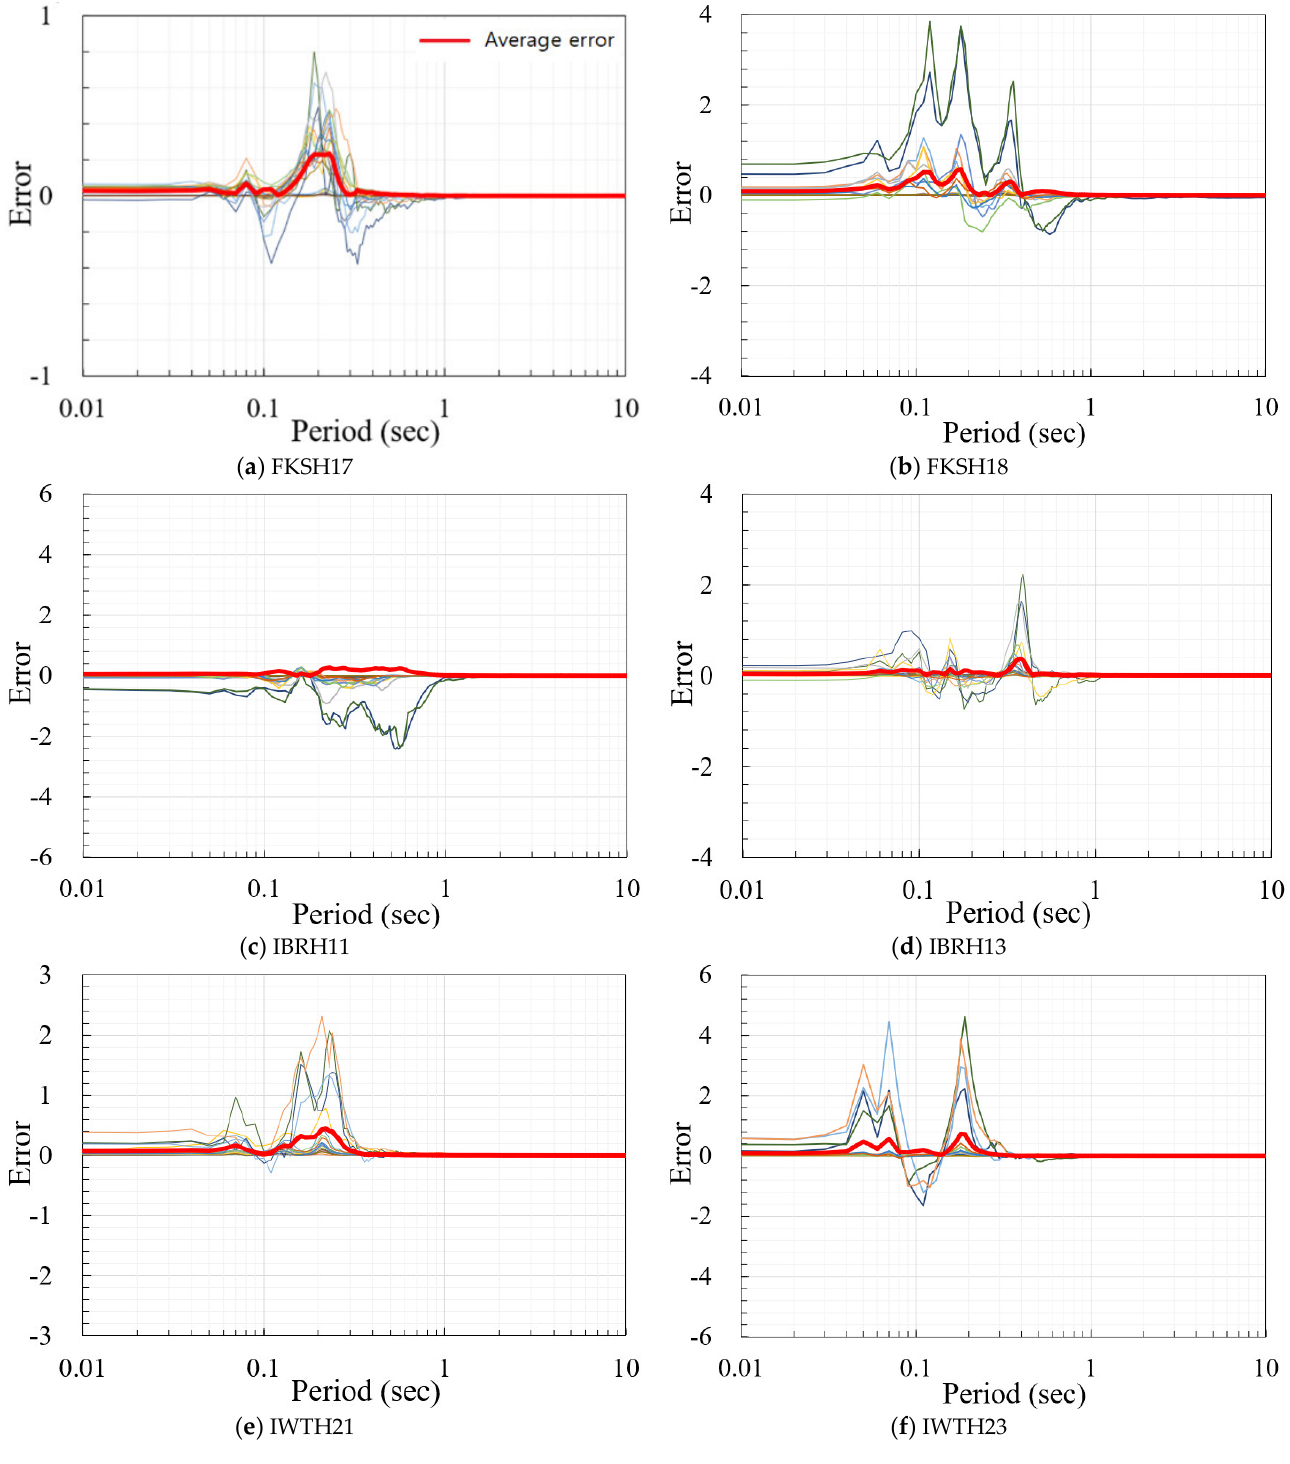
Figure 14. Errors in the ground motions by SHAKE2000.